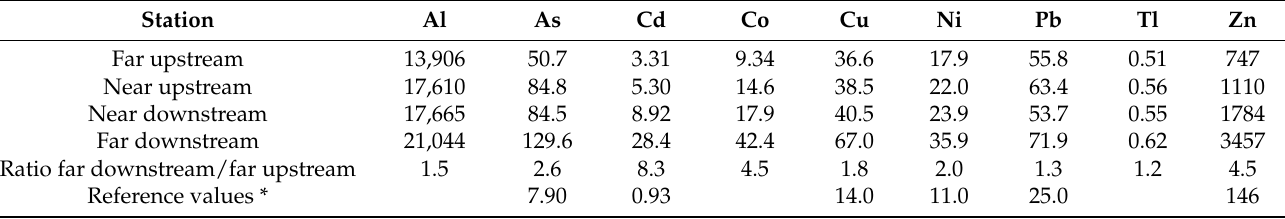
Table 2. Metal concentrations in suspended particles ( µ g.g − 1 ) collected at the different stations.